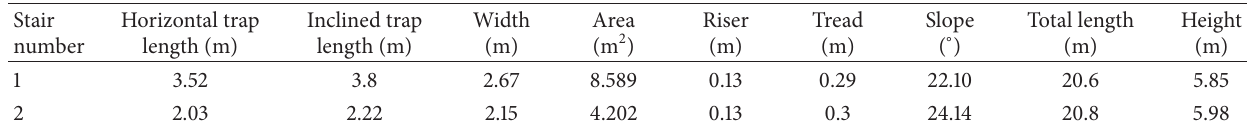
Figure 2: Dadar suburban railway station and network of main lines. Table 1: Dimension of selected